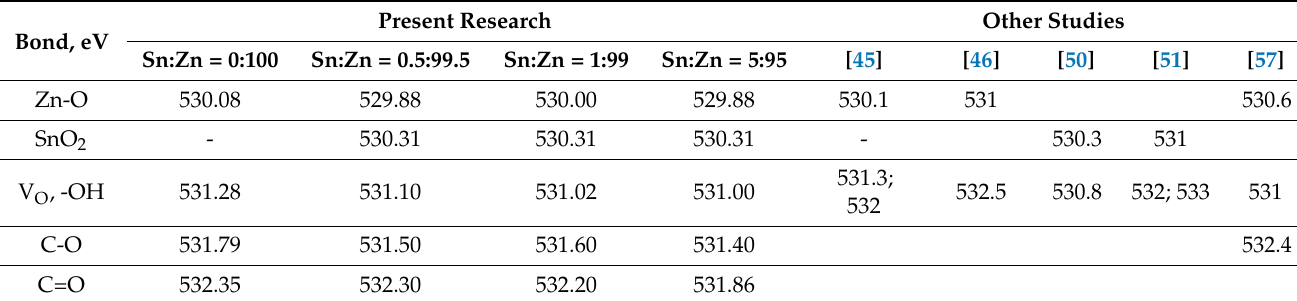
Table 2. The values of the components binding energies for the photoelectron lines of O 1s in zinc and tin oxides. Bond,